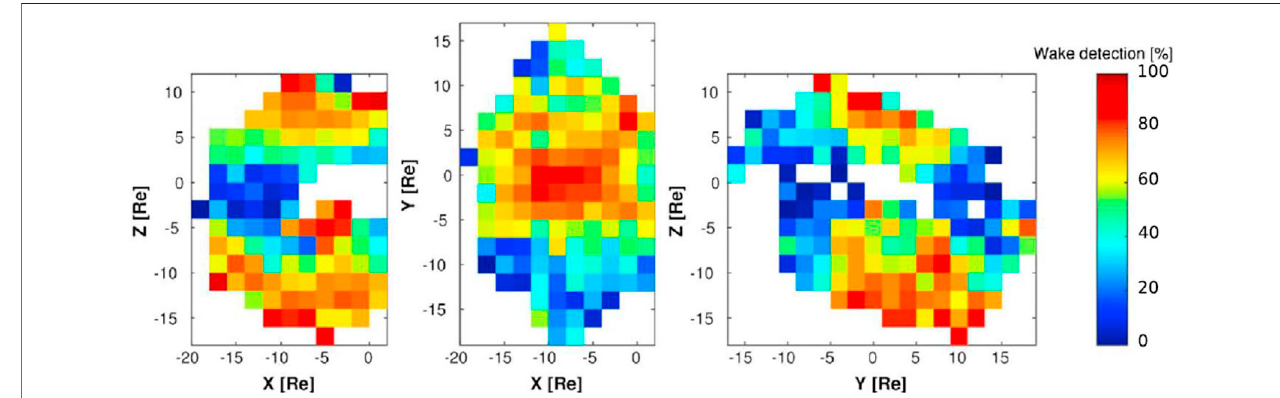
FIGURE 2 | The occurrence rate of cold ions de fi ned by wake detection. A total of about 1,680,000 data are obtained from Cluster 1 and 3 during the years from 2001 to 2010. Adopted from [5].